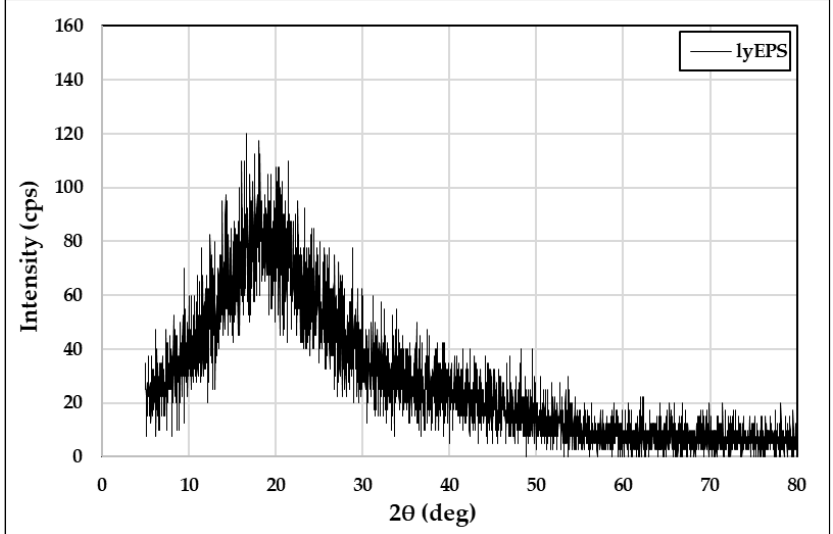
Figure 6. XRD spectra of EPS produced by Lysobacter sp. MMG2 (lyEPS).